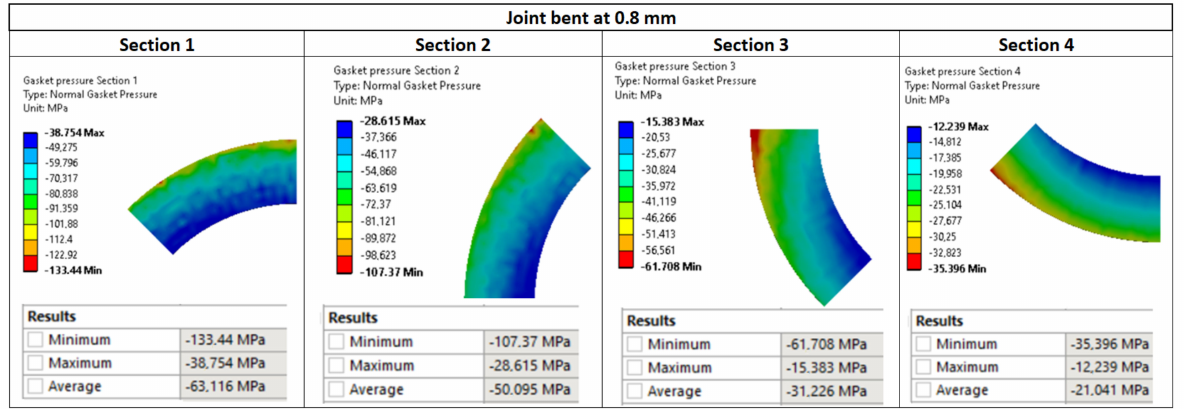
Figure 21. Pressure distribution in the characteristic zones of the gasket—0.8 mm